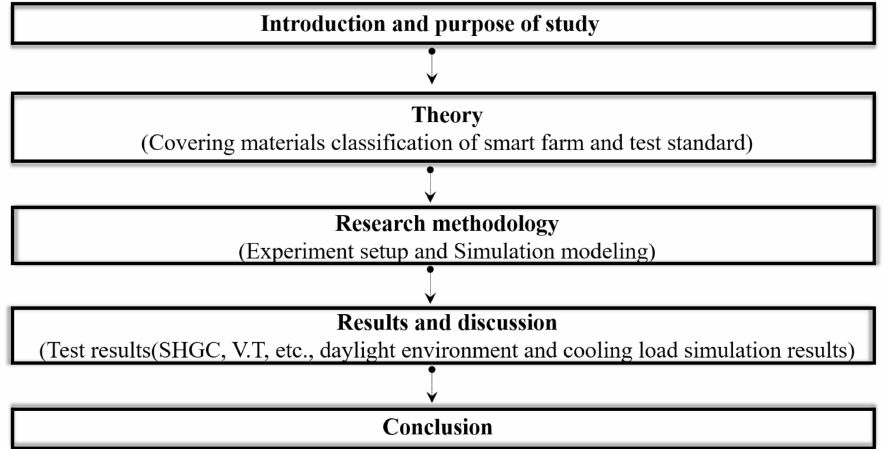
Figure 1. Flowchart of this